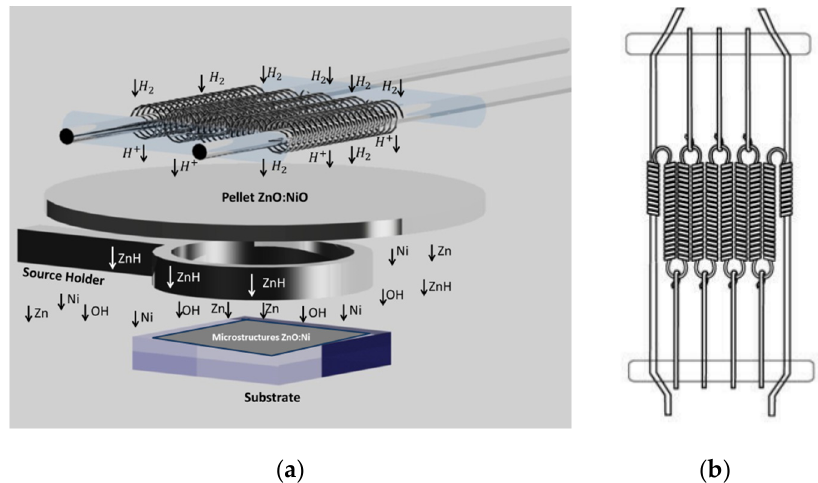
Figure 1. ( a ) Schematic representation of the experimental arrangement. The flow through the HFCVD reactor is vertical, perpendicular to the filaments. It is possible to move the substrate holder to change the deposit temperature. ( b ) Schematic representation of the filament arrangement, the source is under it. H 2 flows through the filament to the source, the substrate holder is under the source. The position of the substrate holder is settled to control the deposit temperature.